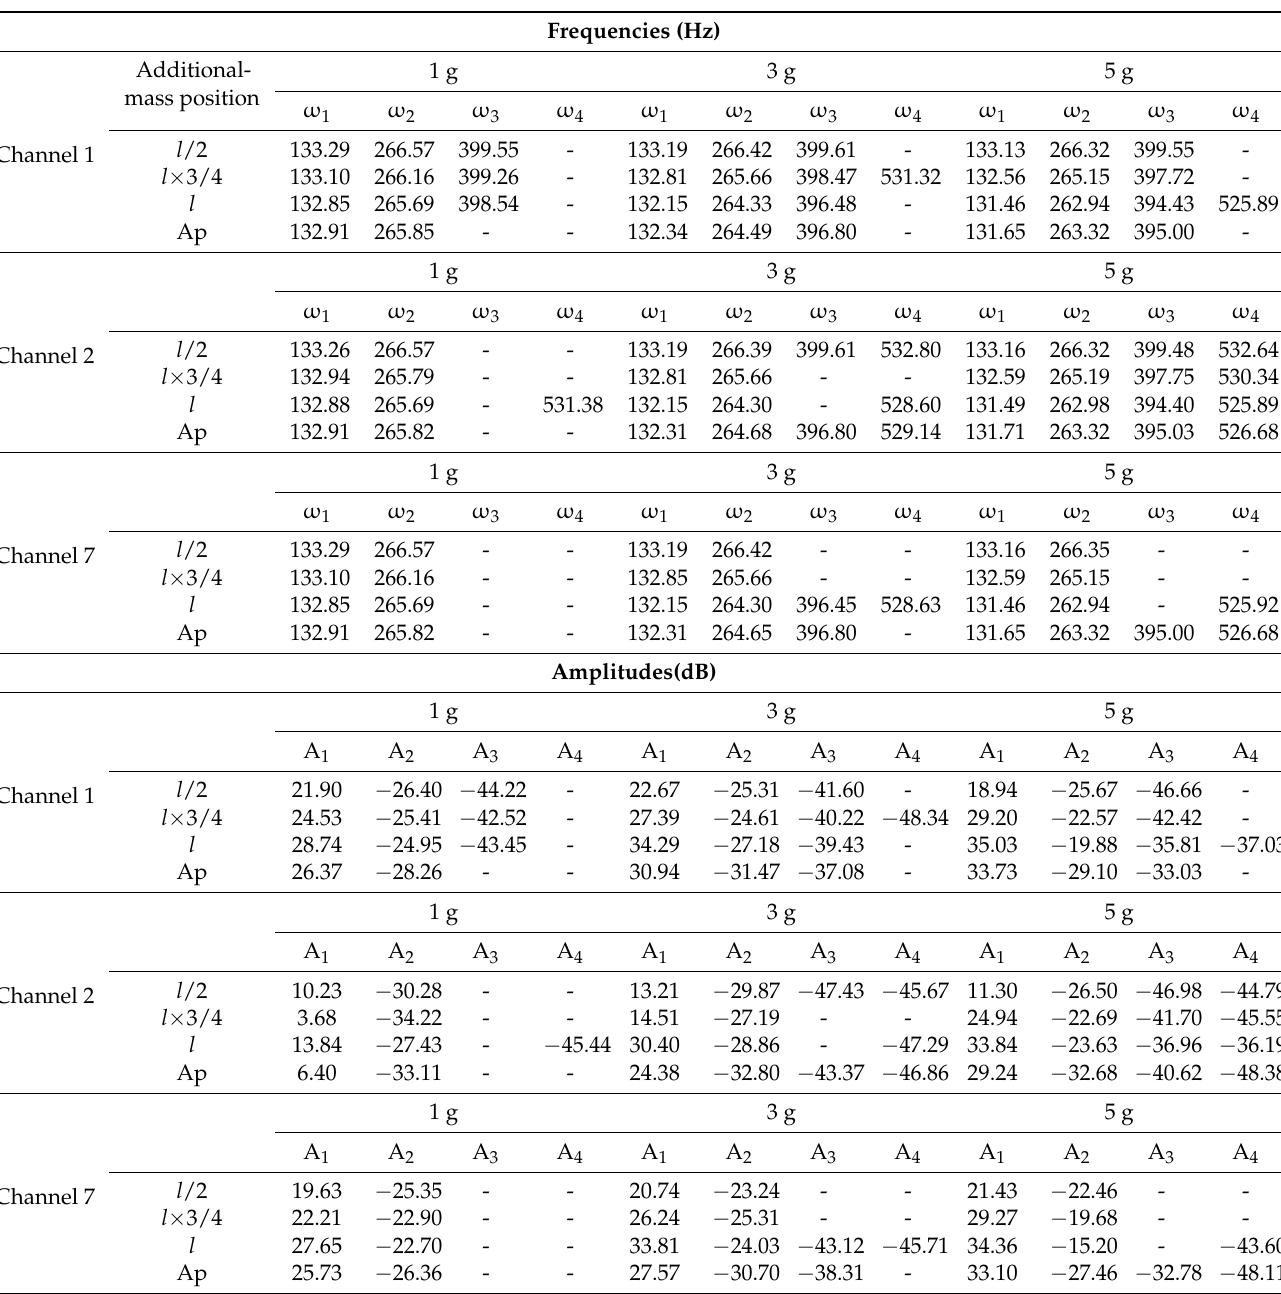
Table 7. Frequencies and